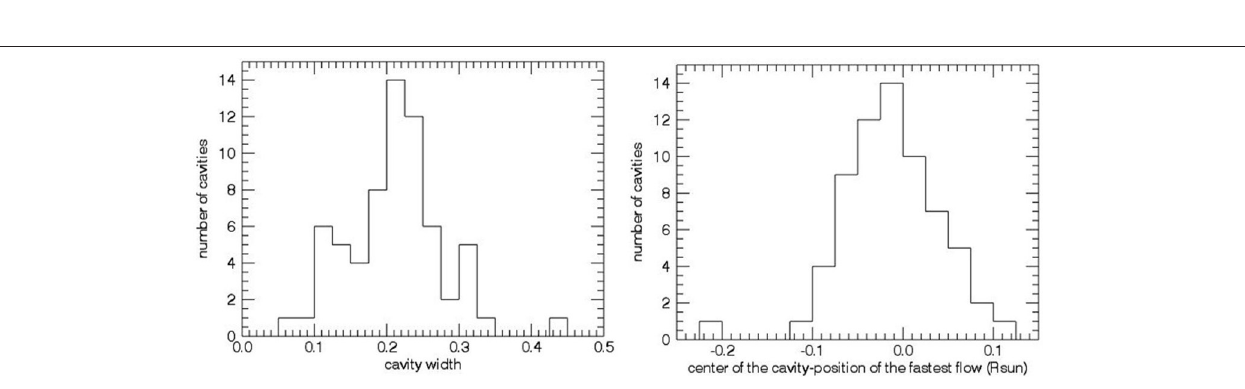
Frontiers in Astronomy and Space Sciences |